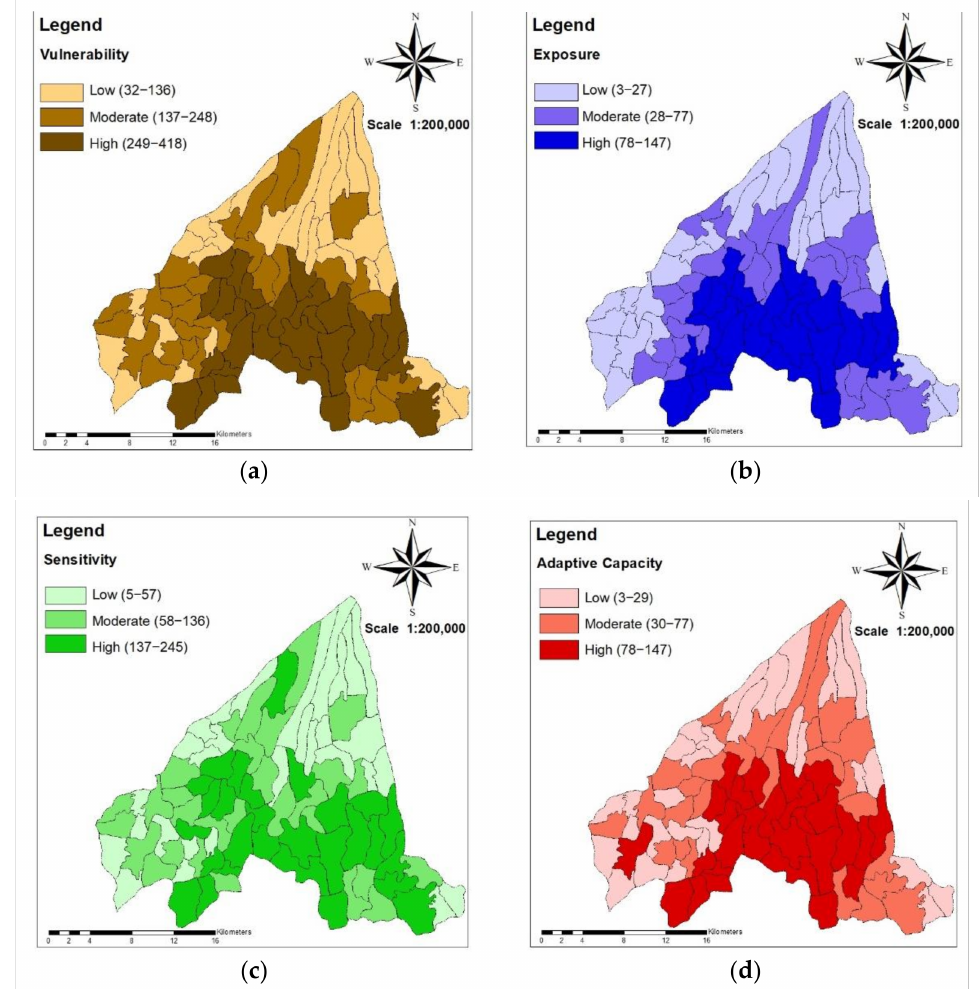
Figure 1. Socio-economic vulnerability map in 2020: ( a ) Vulnerability map; ( b ) exposure map; ( c ) sensitivity map; ( d ) adaptive capacity map (Source: Results of secondary data processing,